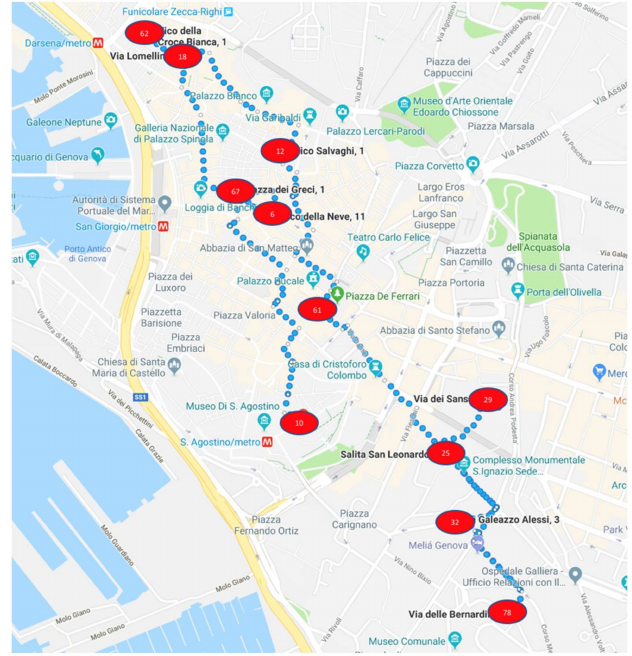
Figure 6. Path of operator